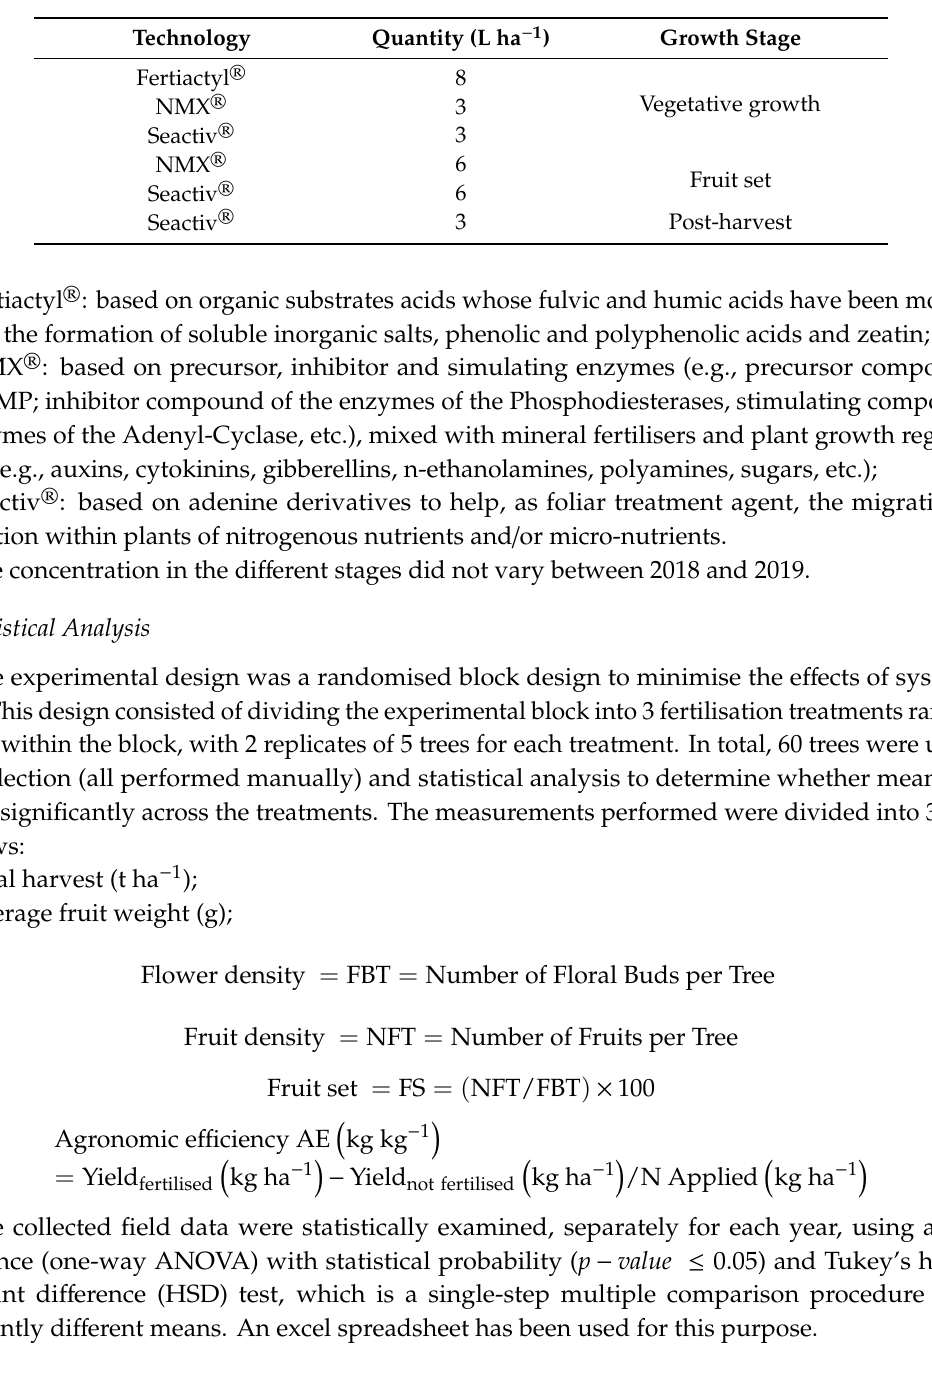
Table 4. Quantity of seaweed-based technologies applied in Timac Agro treatment (TIMAC) treatment and corresponding growth